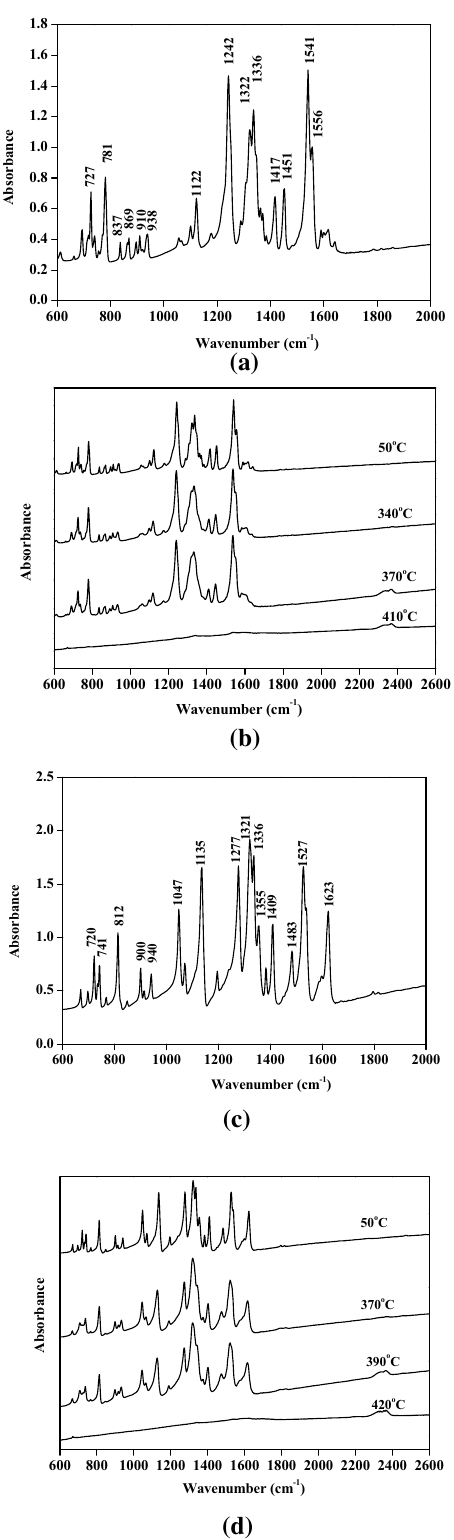
Figure 9. FTIR experiments of y-PTACOT and z-TACOT at room temperatures ( a and c ) and high temperatures ( b and d